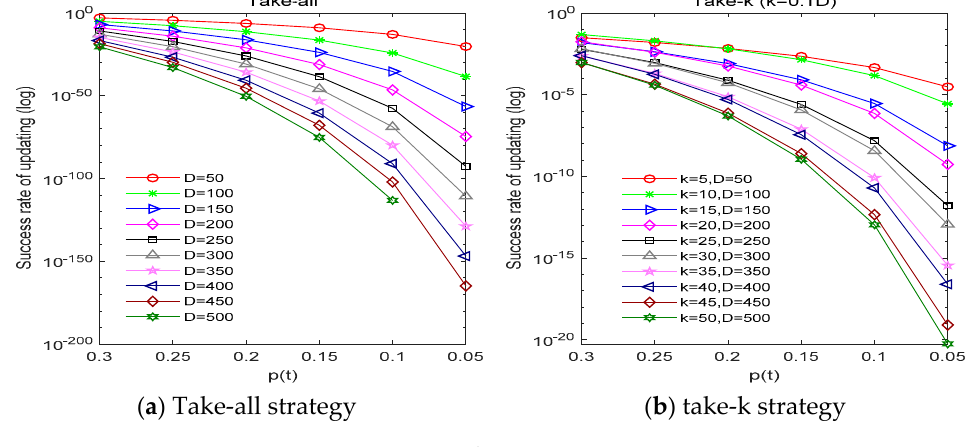
Figure 3. Update success rate.